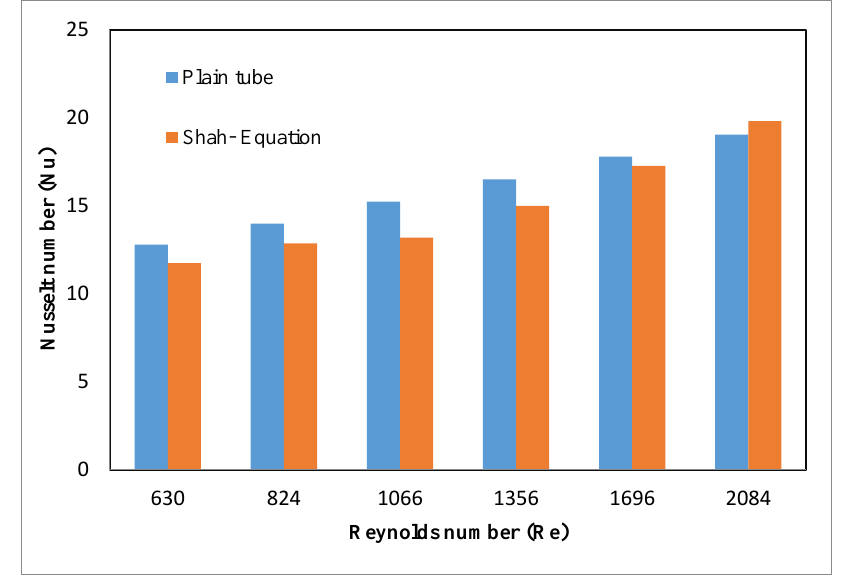
Figure 8. Validation of the experimental Nusselt number for a plain tube under laminar flow.